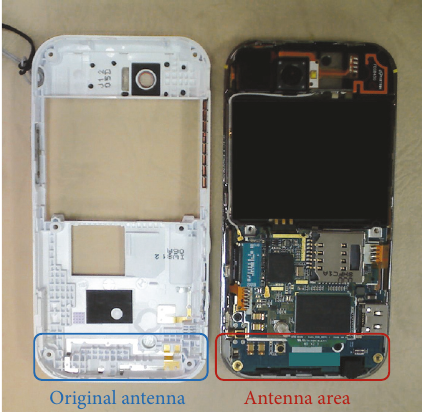
Efficiency Peak Figure 8: Measured radiation efficiency and peak gain of the pro- posed antenna.